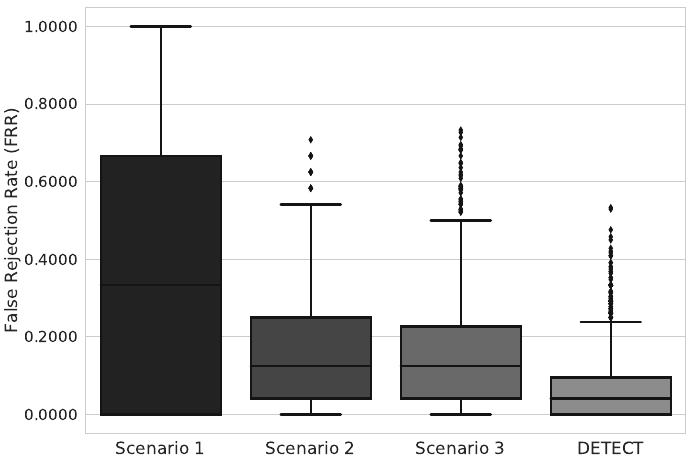
Figure 6. FRR results for each scenario of data improvement